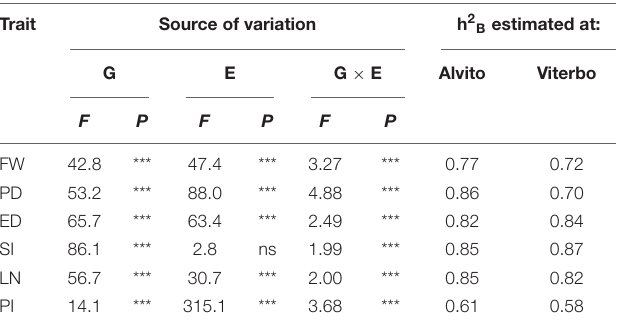
TABLE 1 | Results of the two-way analysis of variance based on the main factors Genotype (G) and Environment (E) and broad-sense heritability (h 2 B ) calculated for the quantitative variables fruit weight (FW), polar diameter (PD), equatorial diameter (ED), shape index (SI), number of locules (LN), and pericarp thickness index (PI) measured in two cultivation environments (Alvito and